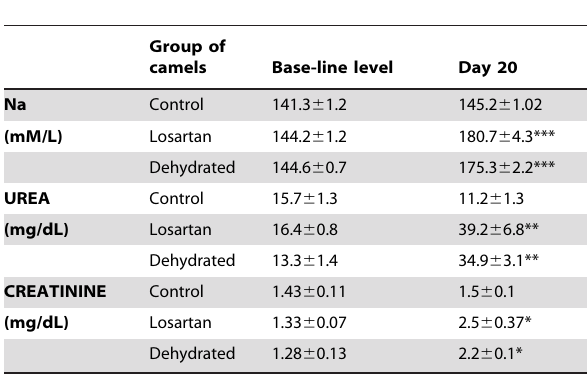
Table 1. Plasma levels of Na, Urea and Creatinine in non- dehydrated (‘‘control’’, n =6), Losartan treated (n=6), and dehydrated camels (n= 18) on Basal day and on day 20 of